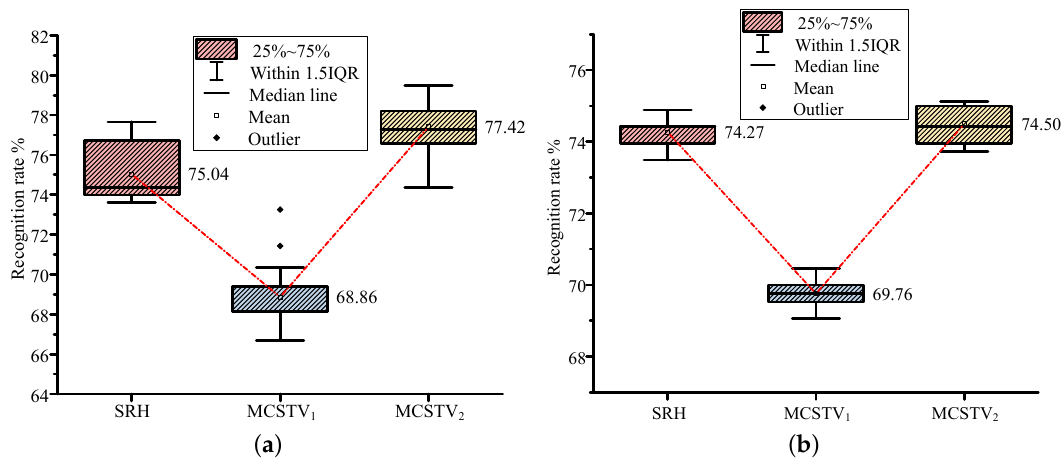
Figure 14. The recognition rate of SRH, MCSTV 1 and MCSTV 2 . ( a ) The results on MSR-Action3D; ( b ) The results on UTD-MHAD.